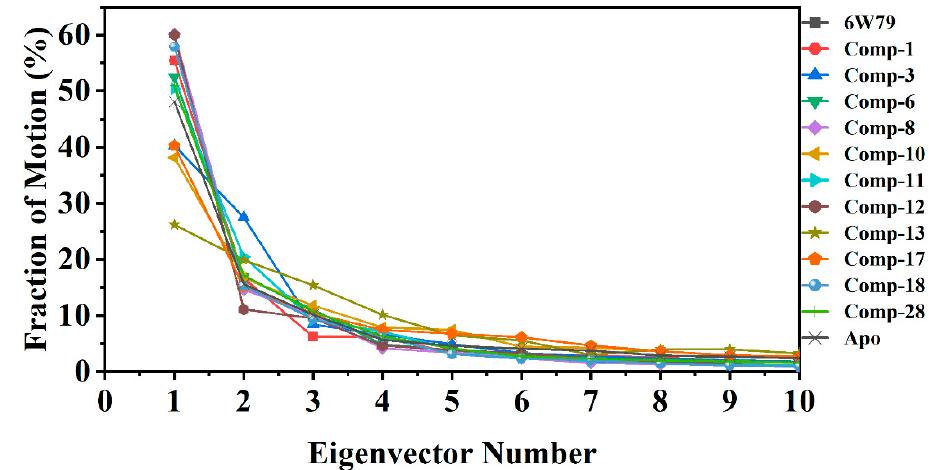
Figure 5. First 10 eigenvector fractions are shown. Each eigenvector contribution (in percentage, %) is acquired from covariance matrix plotted against the corresponding eigenvector from MD trajectory of each complex.